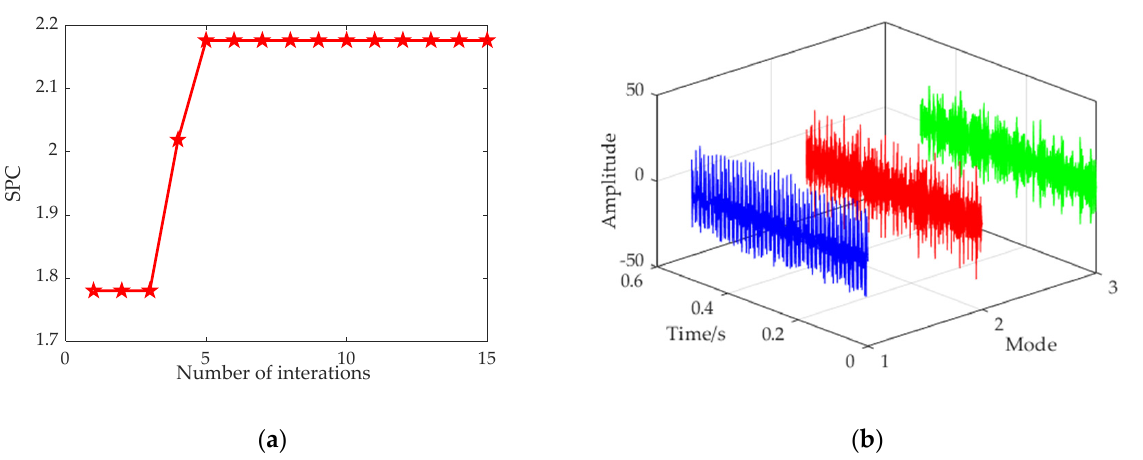
Figure 6. Simulation signal is decomposed by CLNGO-FMD . ( a ) Convergence curve of SPC. ( b ) Time-domain waveform.